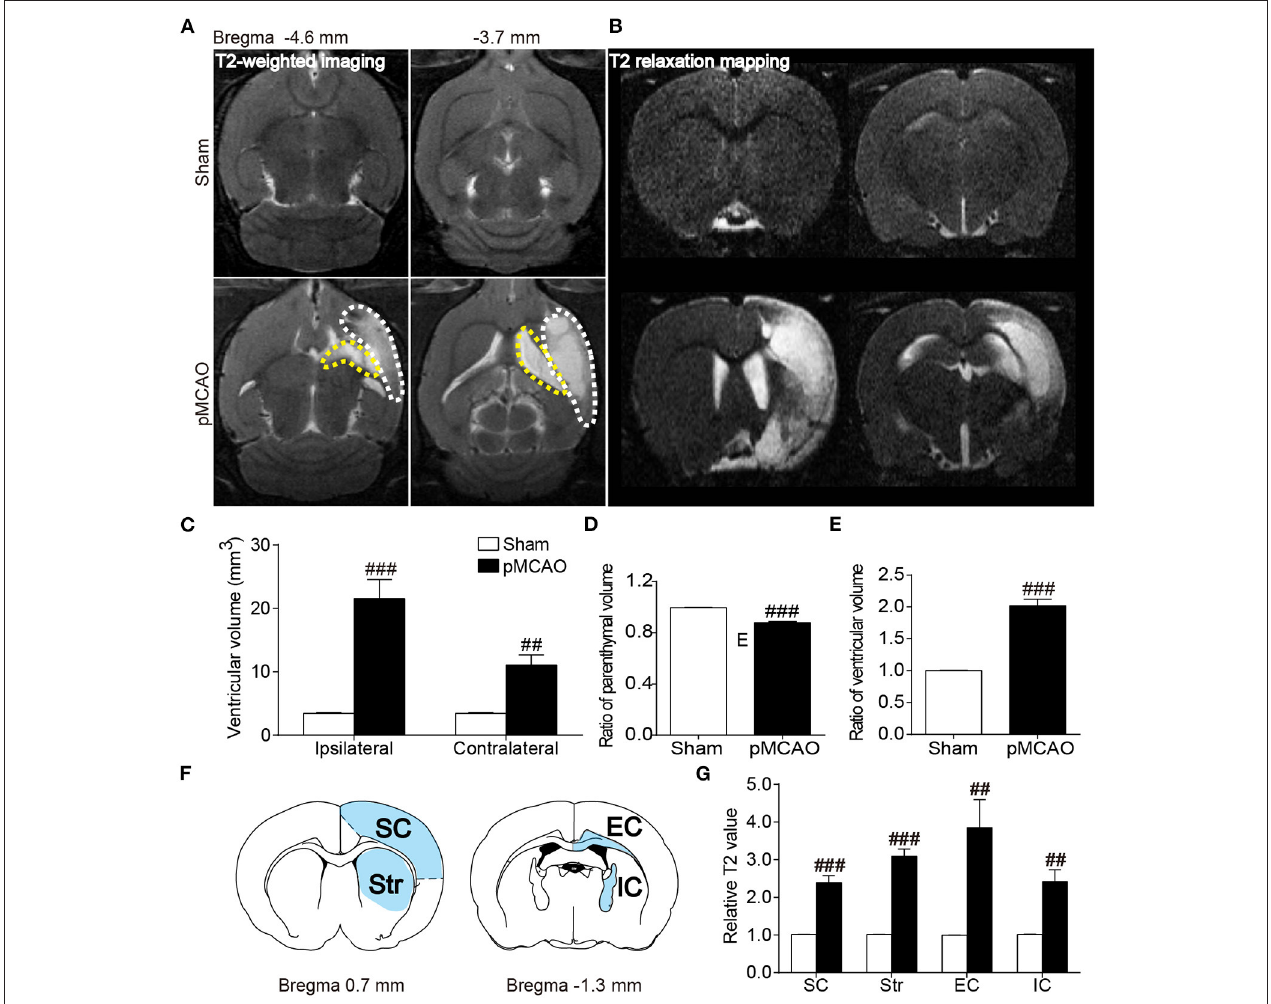
FIGURE 4 | pMCAO induced brain atrophy and structural injury of the gray and white matter in rats. (A,B) Representative axial T2WI and coronal T2 relaxation mapping images of the sham and pMCAO rats. (C–E) Quantitative analysis of the ventricular volume, ratio of parenchymal volume, and ratio of ventricular volume, respectively. (F) Brain atlas showing the regions of interest including sensorimotor cortex (SC), striatum (Str), external capsule (EC), and internal capsule (IC). (G) Quantitative analysis of the relative T2 value (Student’s t -test, N = 8 for the sham group and N = 9 for the pMCAO group). ## P < 0.01, ### P < 0.001 vs. sham